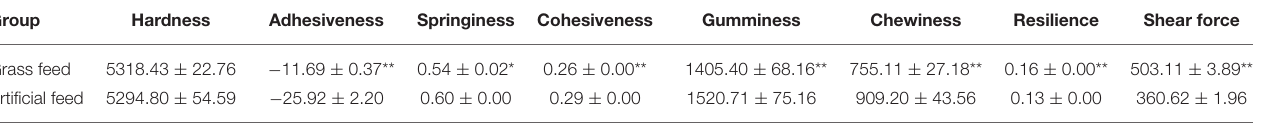
TABLE 4 | Comparison of texture measurements between two feeding model C. idellus .